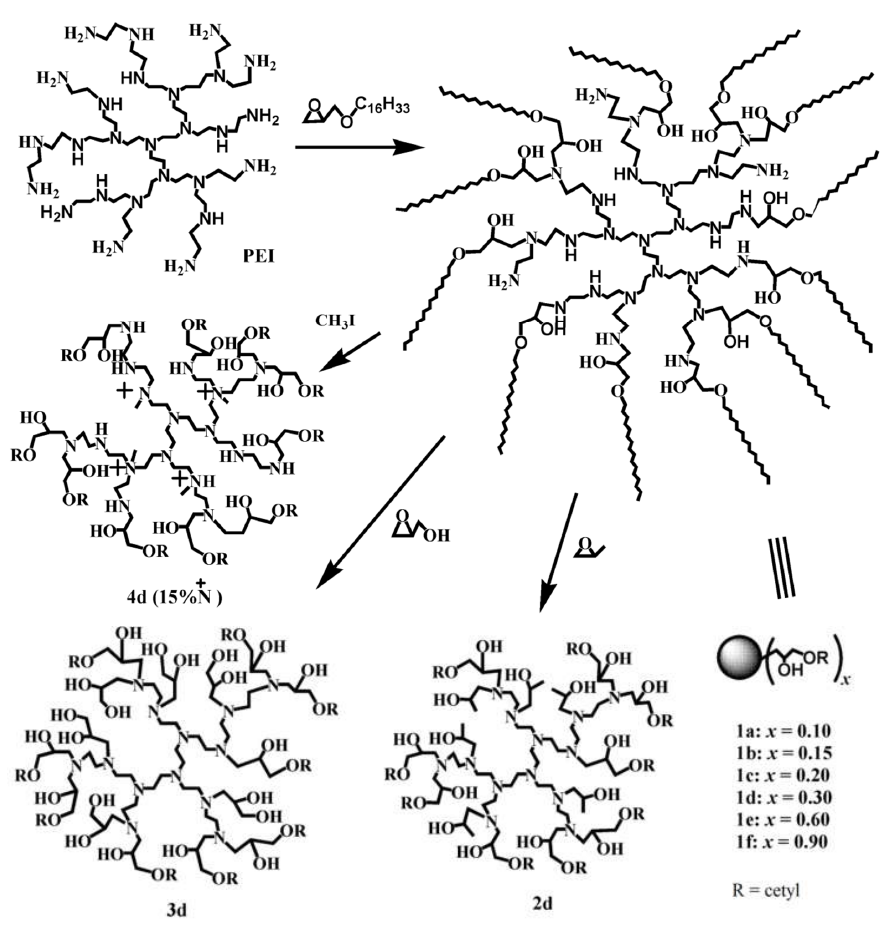
Figure 2. Synthesis of PEI macrosurfactants with different shell densities and core structures [33].